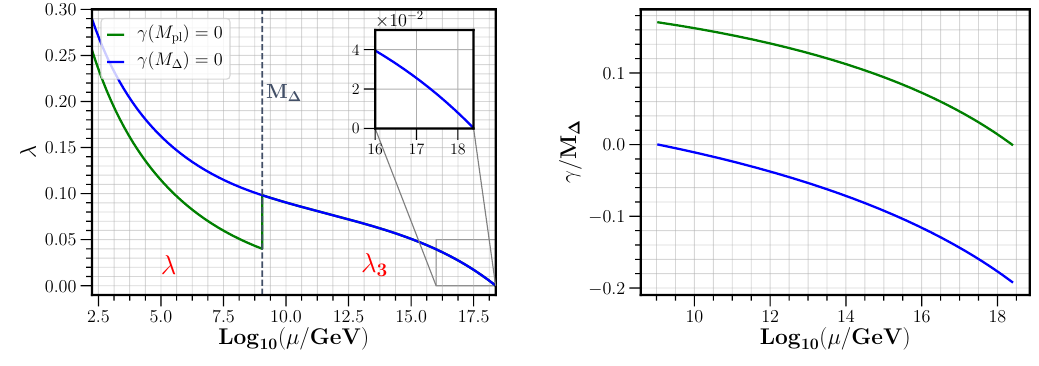
Figure 9 . Left: running of the Higgs quartic coupling with the logarithm of the renormalisation scale in the type I+II seesaw using the 2-loop RGEs. We used the values given in eq. (3.1) for M t = 170 . 97 GeV as well as the extrapolation to M pl described in the beginning of section 3. We required that λ i ( M pl ) = 0 with i = 1 , 2 , 3 , 4 , 5 and used M ∆ = 10 9 GeV , Y ∆ ( M pl ) = 1 and Y Φ ( M ∆ ) = y t ( M ∆ ) which yields a stable doublet-triplet potential. The solid blue line corresponds to γ ( M ∆ ) = 0 and the solid green line to γ ( M pl ) = 0 . One finds λ, λ 3 > 0 for all µ , leading to a stable vacuum. For γ ( M pl ) = 0 (solid blue) there is a step between λ 3 and the effective Higgs quartic coupling λ at M ∆ due to eq. (2.16). Right: running of the cubic coupling γ for the same example as in the left figure. The green and blue lines respectively corresponds to γ ( M pl ) = 0 and γ ( M ∆ ) = 0